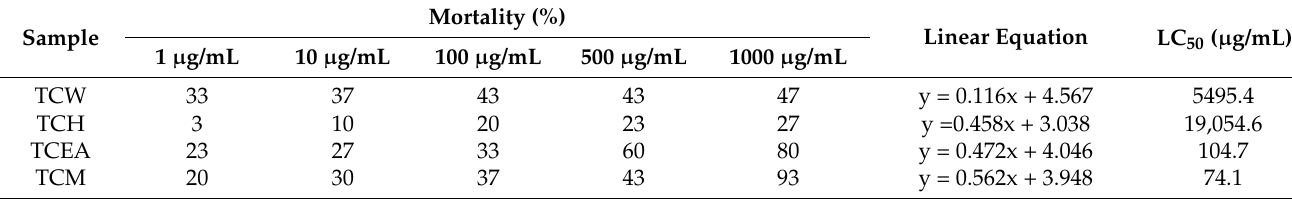
Table 3. Cytotoxicity of cocoa pod husk